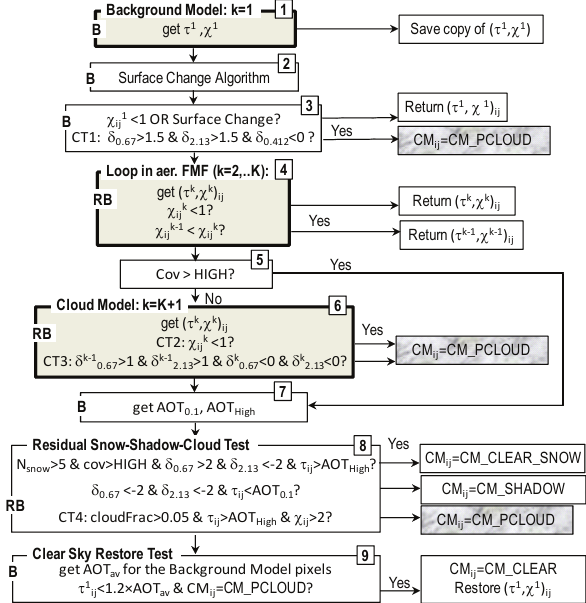
Fig. 2. Block-diagram of MAIAC aerosol algorithm with enhanced cloud-snow-shadow masking. The symbol & stands for